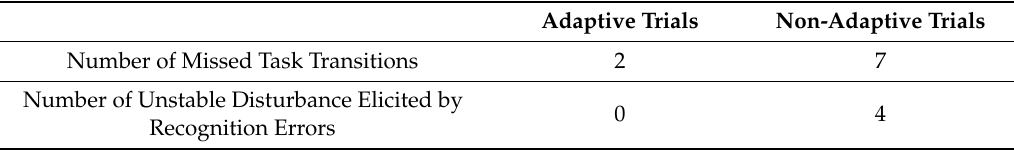
Table 3. The number of missed transitions and unstable